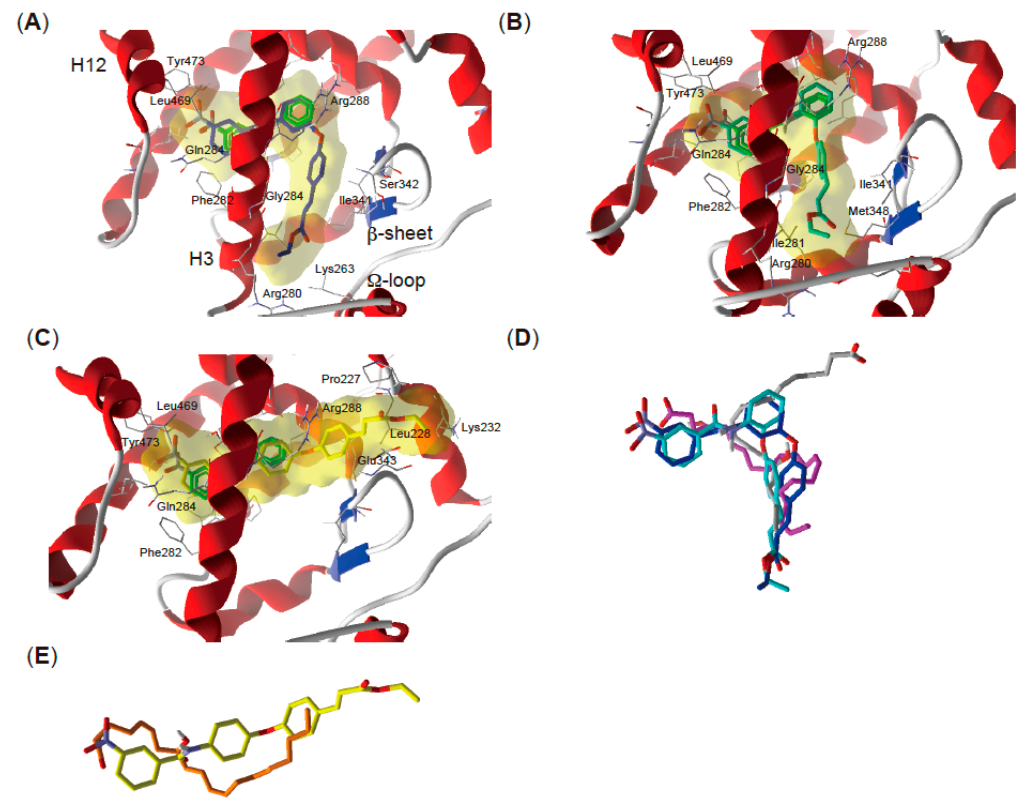
Figure 4. Characterization of the putative binding modes of the synthesized ligands. ( A – C ) Co-crystal structure of the complex between the PPAR γ LBD and GW9662 (green) (PDB code 3B0R), and docking poses of 4a (blue, A ), 4c (cyan, B ), and 4d (yellow, C ). Yellow spheres indicate hydrophobic contacts. ( D ) Superposition of 15-oxo-ETE (gray, PDB code 2ZK4), 4-oxo-DHA (magenta, PDB code 2VV3), and the docking poses of 4a and 4c . ( E ) Superposition of 8-oxo-ETE (orange, PDB code 2ZK3) and the docking pose of 4d .